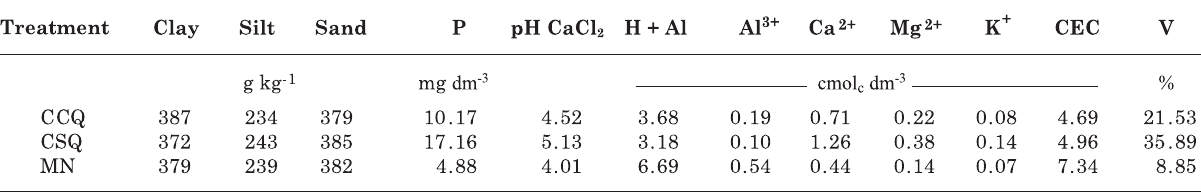
Table 1. Texture and chemical properties of a dystrophic Rhodic Haplustox in the 0–0.20 m layer under burnt cane harvesting (BCH), mechanized cane harvesting (MCH) and native forest